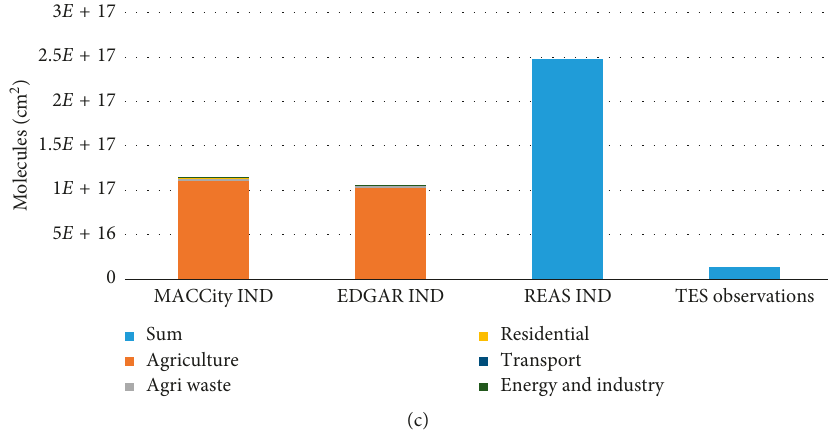
Figure 10: Calculated values for ammonia column densities (molecules/cm 2 ) from the regional and global inventories (MACCity, EDGAR, and REAS) against observed values from the TES instrument on the Aura satellite over (a) South Asia, (b) Pakistan, and (c)